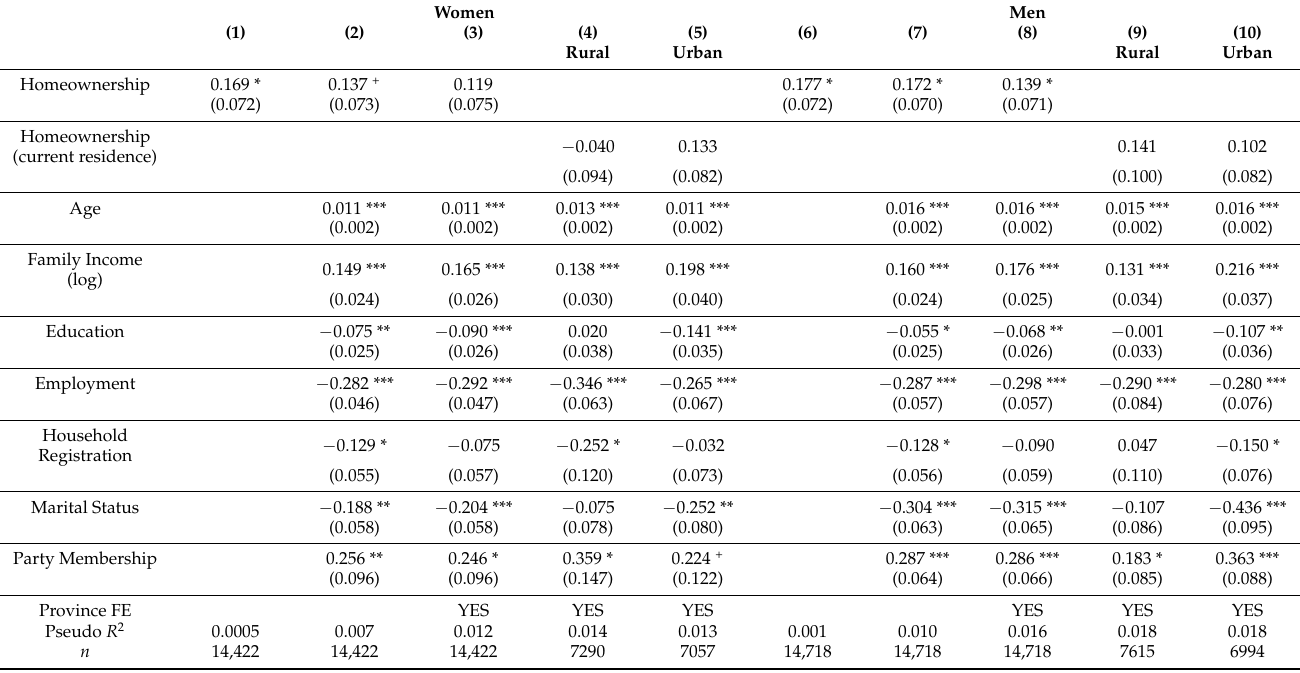
Table 3. Homeownership on Life